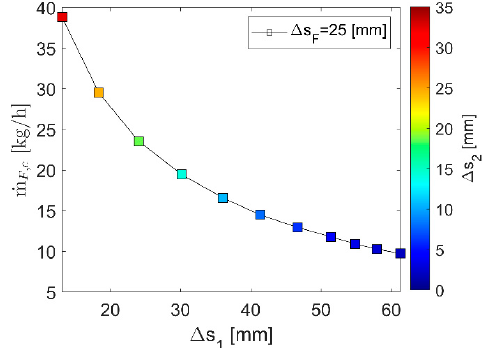
Figure 6. Cooling mass flow rates ( m F , c ) as a function of inner ( ∆ s 1 ) and outer ( ∆ s 2 ) thermal insulation thicknesses at an exemplarily selected cooling fluid gap ( ∆ s F ).